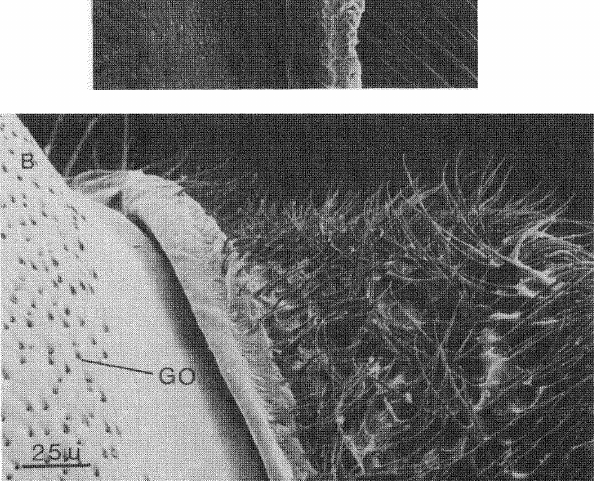
. Fig. 5 A. SEM micrograph of the tergite with the attached intersegmental mem- B. Larger magnification showing clearly the brane of a Neivamvrmex